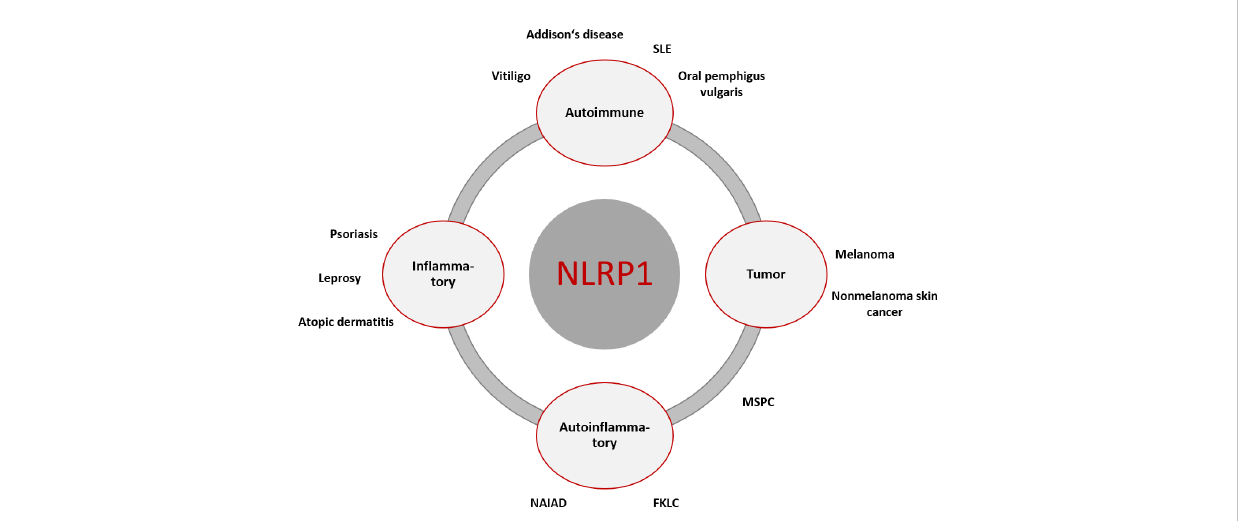
FIGURE 2 Overview of NLRP1-associated diseases with primary cutaneous manifestation or associated cutaneous clinical symptoms. The primary genesis may be in fl ammatory, autoimmune, autoin fl ammatory, and cancerogenic. There is overlap between the different entities, which can lead to symptom complexes that are not clearly assignable diagnostically and therapeutically. [FKLC, familial keratosis lichenoides chronica; MSPC, Multiple Self- Healing Palmoplantar Carcinoma; NAIAD, NLRP1- associated autoin fl ammation with arthritis and dyskeratosis; SLE, systemic lupus